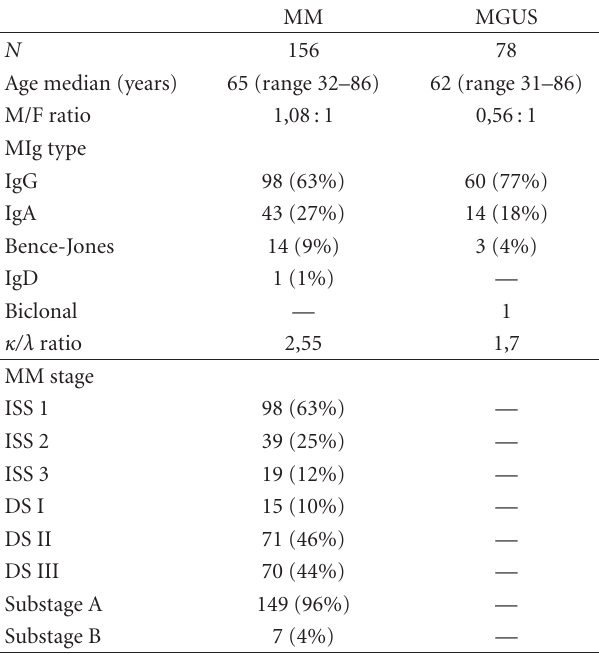
Table 1: Characteristics of the analyzed